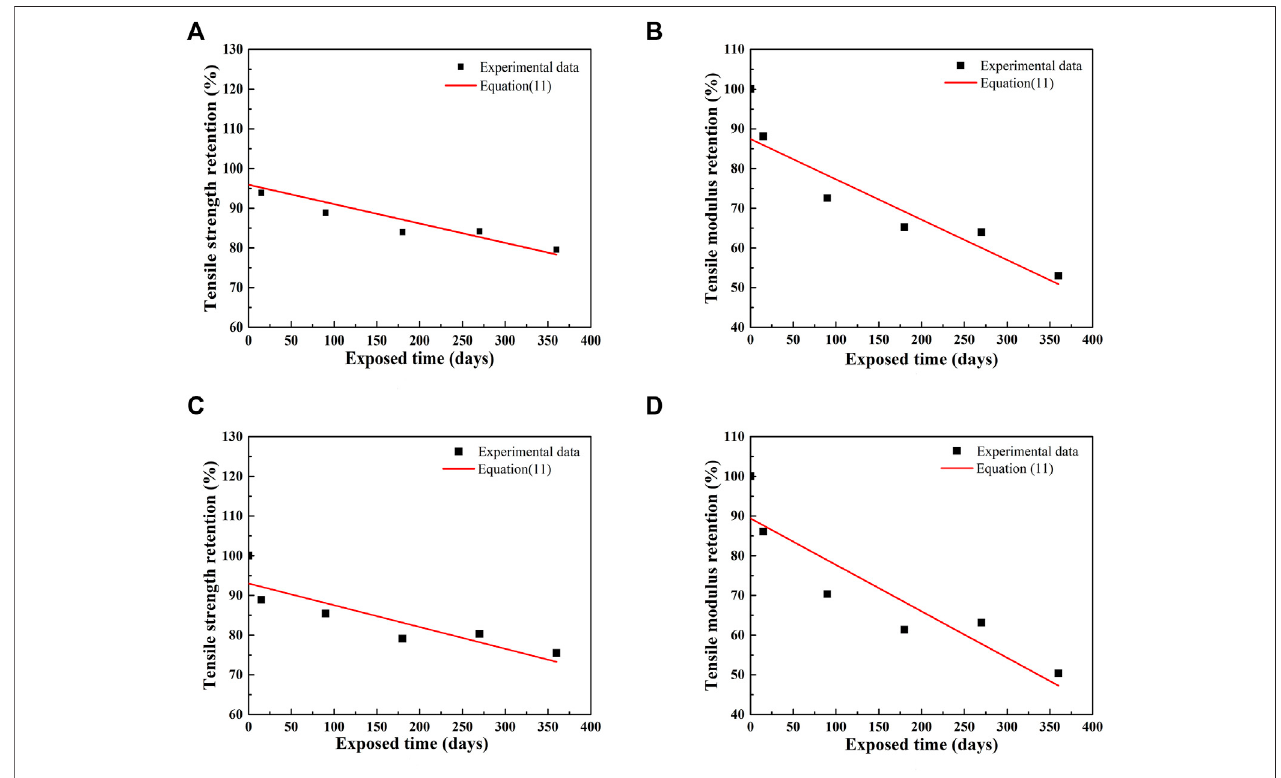
FIGURE11| Comparisonofthepredictionof (A) tensilestrengthofpultrudedUPGFRPpro fi lesunderthecombinedhygrothermalcondition, (B) tensilemodulusof pultrudedUPGFRPpro fi lesunderthecombinedhygrothermalcondition, (C) tensilestrengthofpultrudedUPGFRPpro fi lesunderthecombinedhygrothermalcondition with sustained loading, and (D) tensile modulus of pultruded UP GFRP pro fi les under the combined hygrothermal condition with sustained loading.